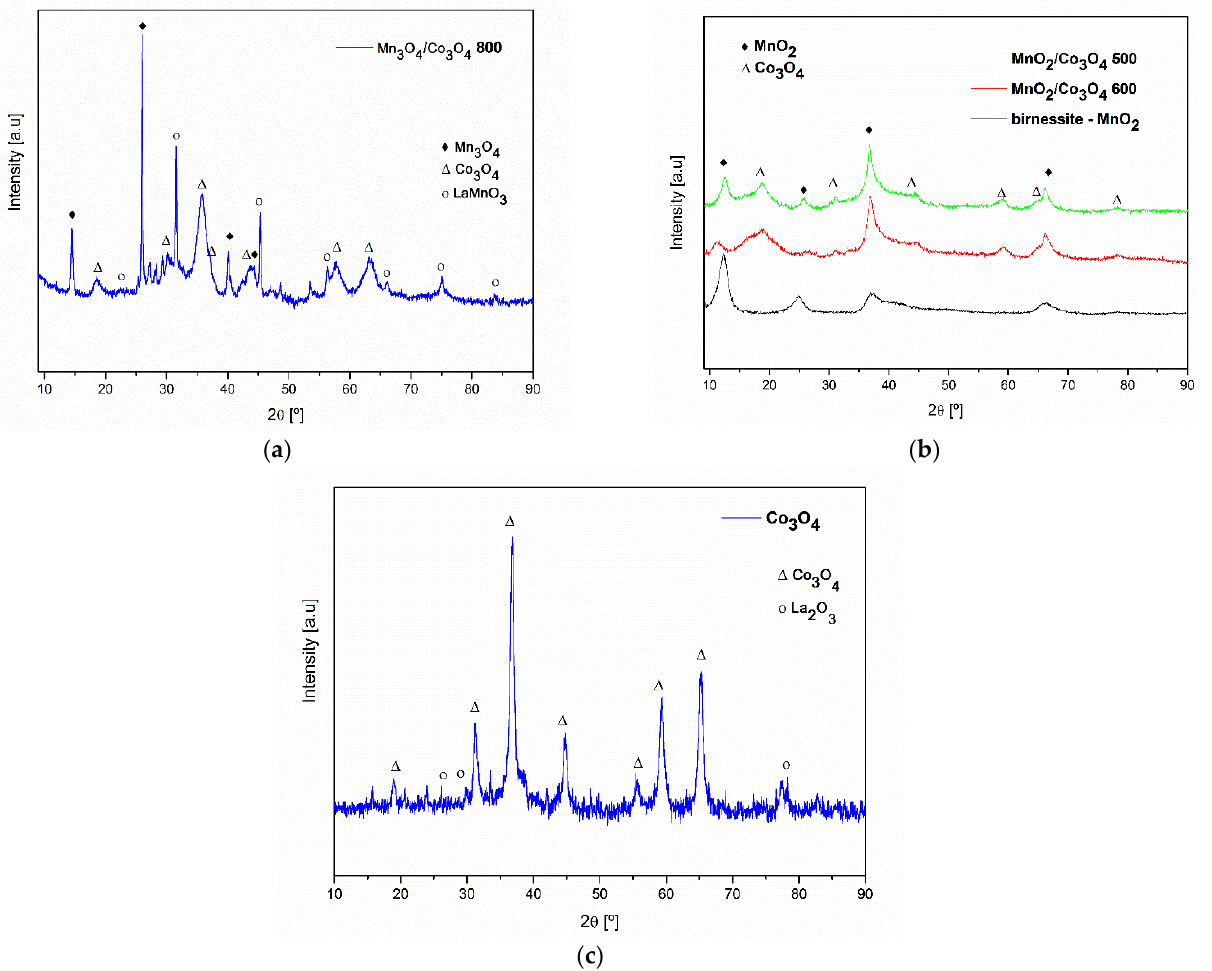
Figure 1. XRD patterns of ( a ) Mn/Co/La oxide hybrid materials synthesized on 500 and 600 °C, and commercial MnO 2 ; ( b ) Mn/Co/La oxide material synthesized at 800 °C; ( c ) Co/La oxide hybrid material.